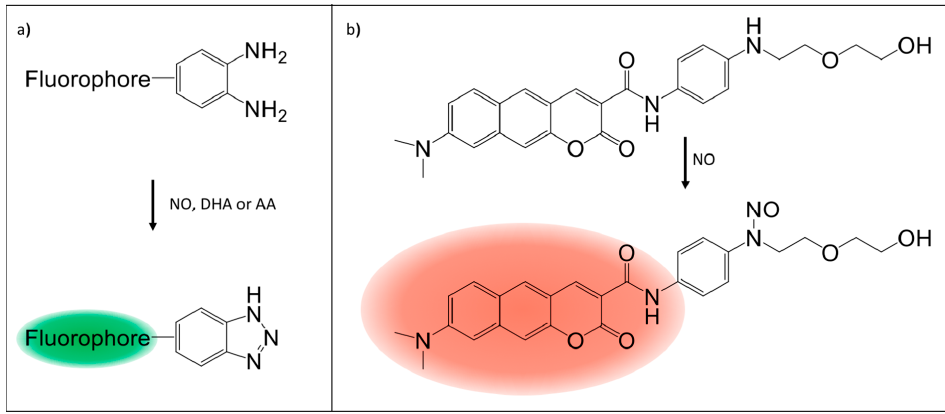
Figure 4. Comparison of a common o -diamino aromatic probe with the new NCNO probe. ( a ) shows a generic o -diamino aromatic probe that is activated by exposure to nitric oxide (NO), dehydroascorbic acid (DHA), or ascorbic acid (AA); ( b ) shows the NCNO probe that is also activated by NO, but not by DHA or AA